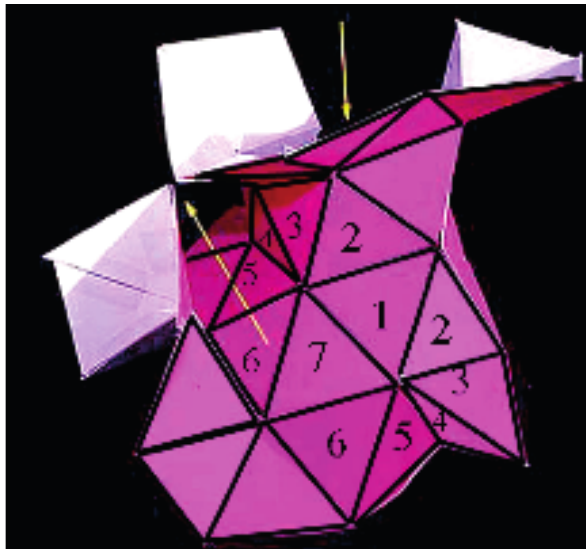
Figure 24. A faceted model of the hyperbolic plane, containing sev- en equilateral triangles at every vertex. Th e arrows mark pores.